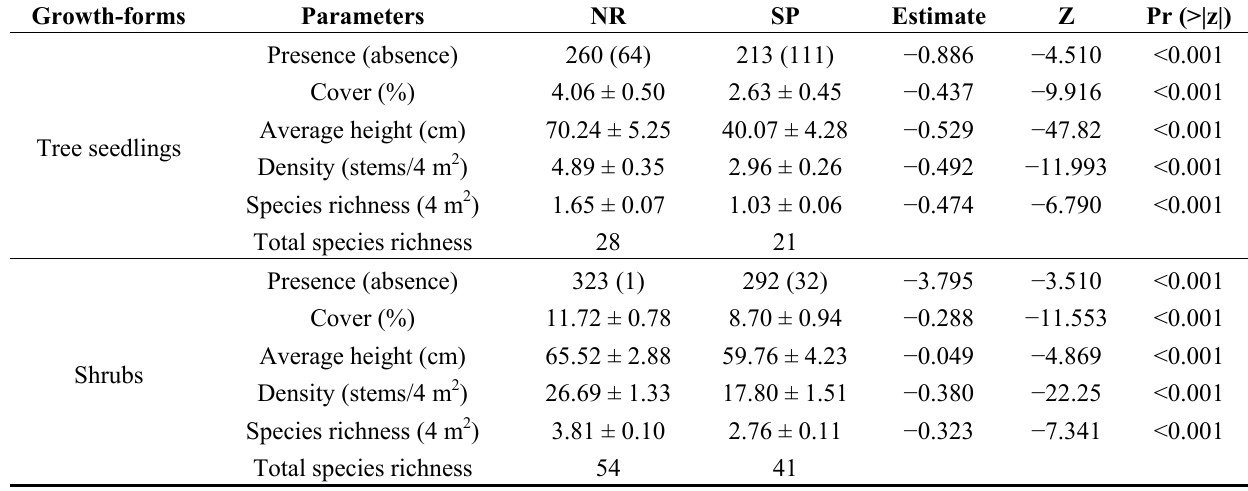
Table 2. Species richness and structural parameter values (mean ± SE) of growth-form species groups and their differences in the naturally regenerated forests (NR) and the reforested spruce forests (SP) originating from similar clear-cuts in the eastern Tibetan Plateau. The difference between the NR and the SP was tested by generalized linear mixed-effects models (GLMMs). Treatment (NR vs. SP) was introduced as a fixed factor and stands (12 vs. 12) as a random factor, with three plots nested in each stand, and nine quadrats nested in each plot. In each case, Poisson error distribution with log-link function was selected in GLMMs, except binomial error distribution with logit-ling function for the presence (1) and absence (0) of each growth